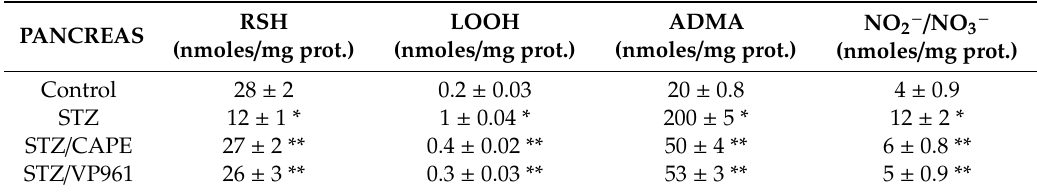
Table 3. Pancreatic RSH, LOOH, ADMA, and NO 2 − / NO 3 − levels. RSH LOOH PANCREAS (nmoles / mg prot.) (nmoles / mg